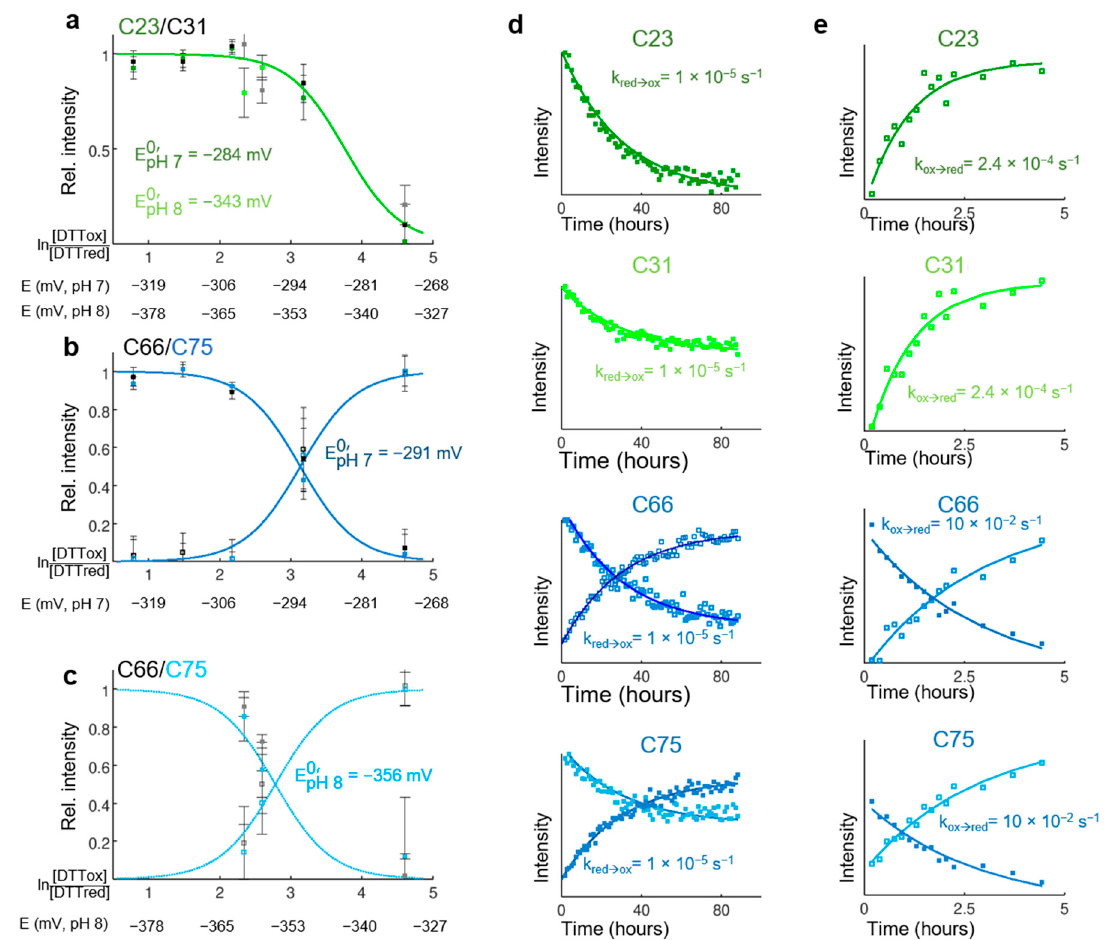
Figure 6. Redox transition of isolated CP12. ( a ) Thermodynamics of the redox transition for the N -terminal disulfide bridge. Signal intensities at NMR frequencies of reduced cysteine residues C 23 (dark and light green) and C 31 (grey and black), plotted as a function of the logarithm of the measured [ DTT ox ]/[ DTT red ] ratio (refer to Material and Methods). The corresponding electropotentials at pH 7 or pH 8 are indicated below. The redox titration was performed at pH 7 (dark green and black) and pH 8 (light green and grey). ( b ) Thermodynamic of the redox transition for the N -terminal disulfide bridge measured at pH 7. Signal intensities at NMR frequencies of reduced (filled squares) and oxidized (open squares) cysteine residues C 66 (dark blue) and C 75 (black), plotted as a function of the logarithm of the measured [ DTT ox ]/[ DTT red ] ratio (refer to Material and Methods). The corresponding electropotential at pH 7 is indicated below. ( c ) Same as B at pH 8. The color coding is light blue for C 66 and grey for C 75 . The redox mid-potential of the C 66 –C 75 disulfide bridges at pH 8 is more different than that at pH 7 than the expected − 59.1 mV difference per pH unit. ( d ) Kinetic of the oxidation. Signal intensity as a function of time after buffer exchange in air-oxidized at NMR frequency of reduced C 23 (top), reduced C 31 (below), reduced and oxidized C 66 (below, open, and filled square, respectively), and reduced and oxidized C 75 (bottom, open, and filled square, respectively). The fits using the equations I I (cid:3415) = e (cid:2879)k red→ox t +c and I I (cid:3415) =c - e -k red→ox t are shown, where c is a constant, k is the rate constant of the oxidation of cysteine residues. The kinetic of the oxidation for all CP12 residues is shown in Figure S7. ( e ) Kinetic of the reduction. The color coding is the same as above. The fits using the equations I I (cid:3415) =e (cid:2879)k ox→red t +c and I I (cid:3415) =c - e (cid:2879)k ox→red t are shown, where c is a constant, k is the rate constant of the transition from oxidized to reduced cysteine residues. The reduction rate for all CP12 residues is shown in Figure S8.